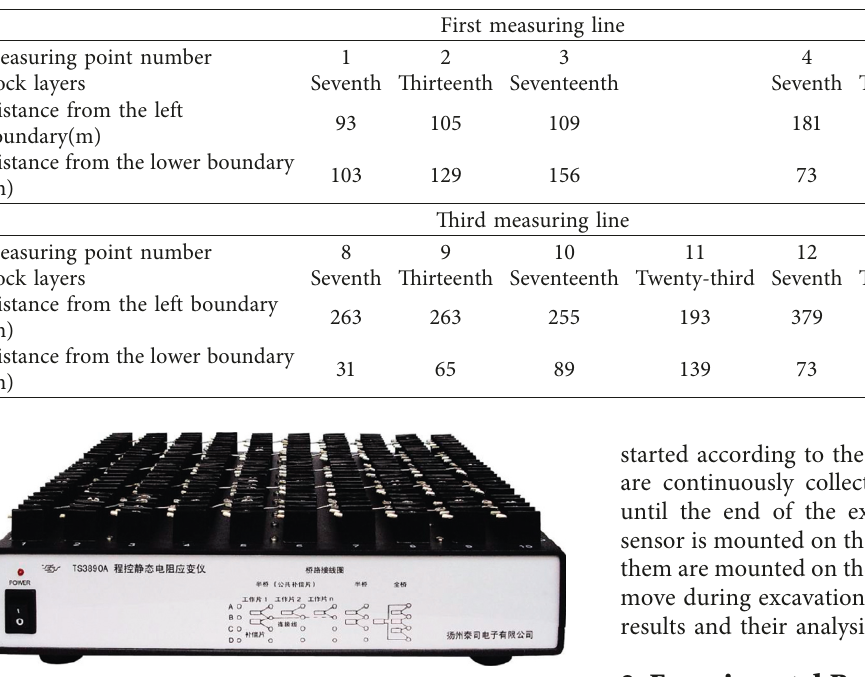
Figure 3: TS3890 static strain measuring and processing